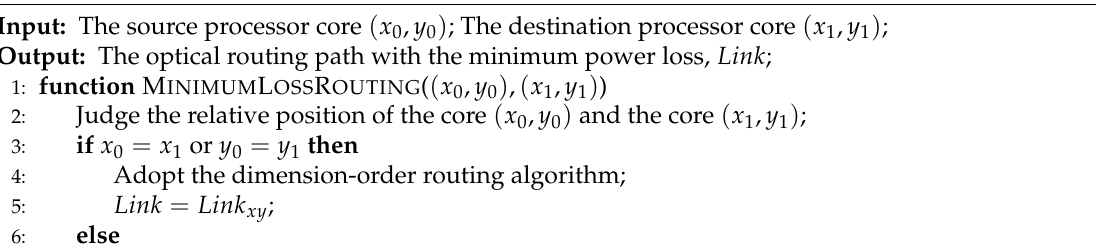
Algorithm 1 Routing algorithm for minimum power